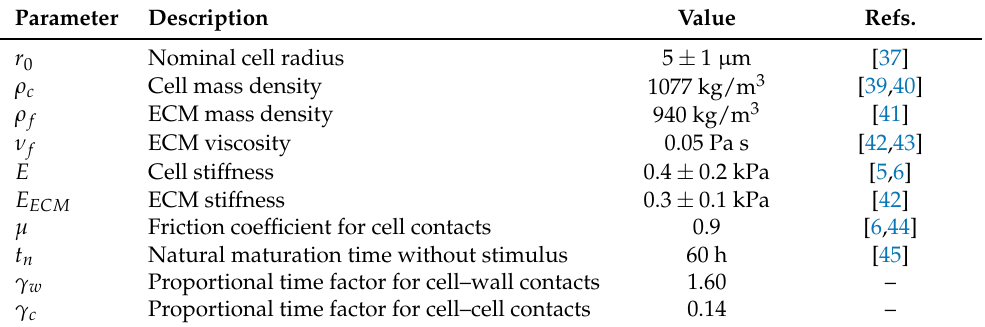
Table 1. Mechanical parameters considered in the